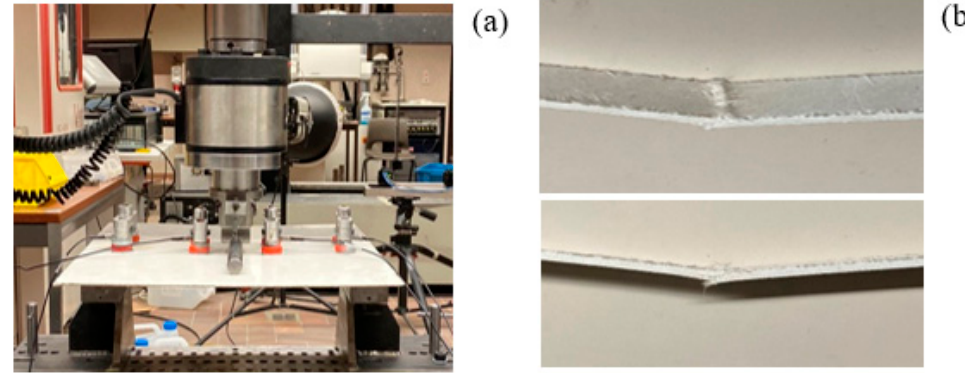
Figure 5. ( a ) Three-point bending setup for the TRC plate (the same setup was used for the TRC beam). The magnetic clamps holding the four AE sensors are visible on the plate. ( b ) Fractured TRC beam after the end of the test.